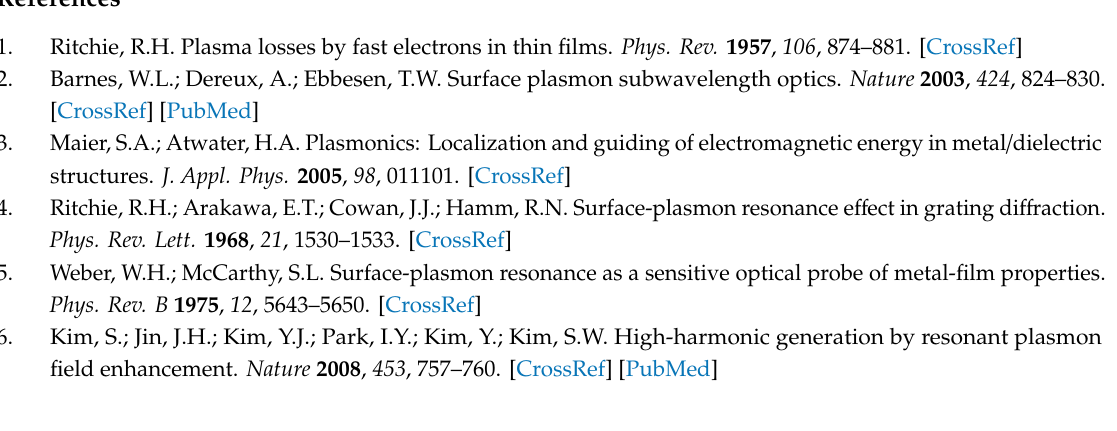
Figure 7. Dependence of the peak wavelength of the electromagnetic field enhancement factors at the tips of spheroidal nanoparticles of Au, Ag, Cu, Pd, Ti, and Ni on the aspect ratio in ( left ) air / H 2 / vacuum and ( right ) H 2 O.